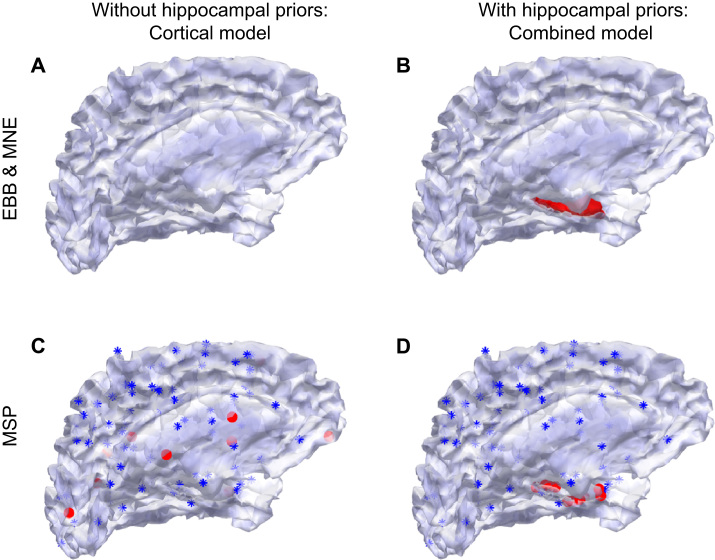
Anatomical models with and without hippocampal priors. A Implementation of the cortical model in the EBB and MNE algorithms. The tessellated cortical surface envelope is comprised of 10595 vertices. B Implementation of the combined model in the EBB and MNE algorithms. This model which includes a nested hippocampal manifold and contains 10757 vertices. C and D show the cortical and combined model implementations for MSP. The full source space is specified in both models such that each includes the nested hippocampal mesh and the number of vertices is 10757. Instead of vertices, the solution space is constrained by the spatial priors. In both models, 90 blue asterisks mark identical cortical prior locations. In C, an additional ten cortical priors are specified, marked here as red dots. In D, an additional ten hippocampal priors are specified, marked also as red dots. (For interpretation of the references to color in this figure legend, the reader is referred to the web version of this article.)